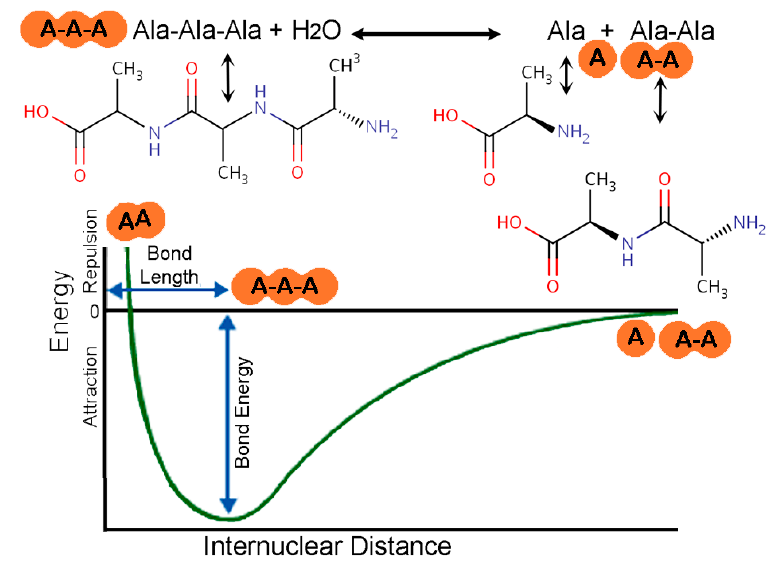
Figure 1. Energy diagram of the way that mechanochemistry might polymerize molecules, such as Alanine (A), shown here. ( Top ) tri-alanine, A-A-A, forming, reversibly from, alanine and di-alanine (A-A), with the release of a water molecule. ( Bottom ) Mechanical force vs. distance curve showing Attractive and Repulsive regimes as molecules are pushed closer together, to the bonding distance. Modified from [33].